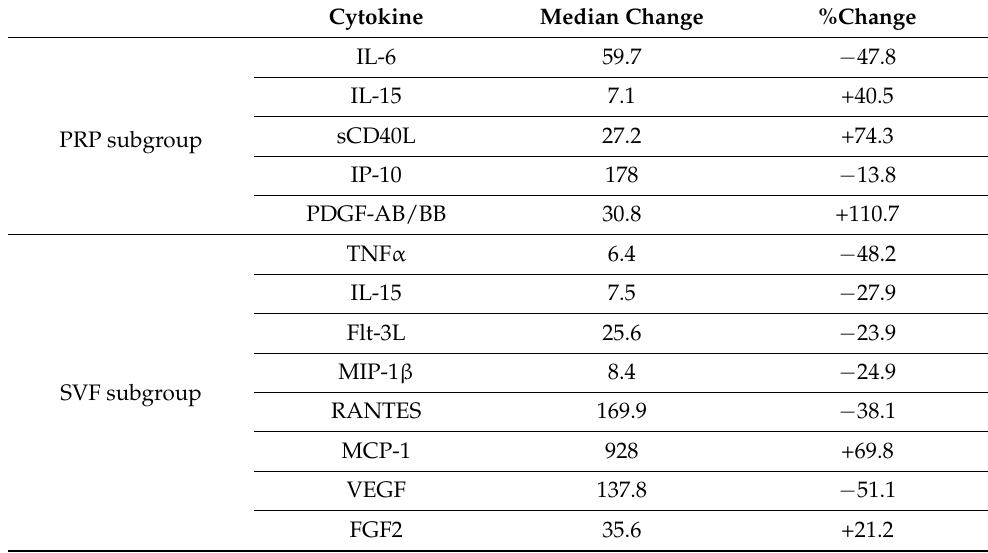
Table 2. Changes in synovial fluid cytokine concentrations (pg/mL) in patients with OA subjected to HTO therapy prior to post-surgery injections of PRP or SVF and one week